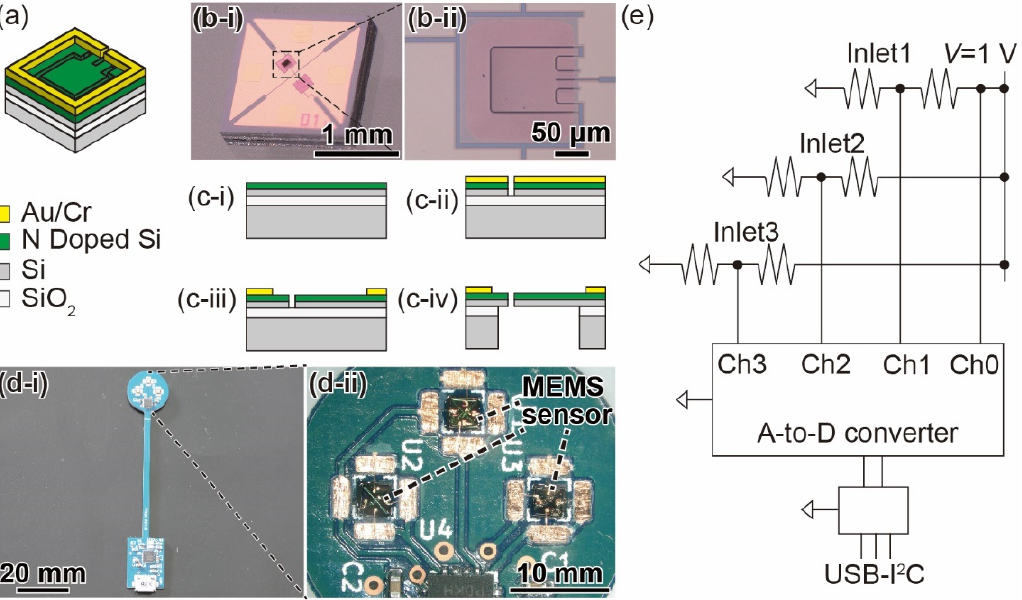
Figure 3. ( a ) Schematic diagram of the piezoresistive cantilever. ( b ) Photographs of ( i ) the MEMS DP sensor chip and ( ii ) the piezoresistive cantilever. ( c ) Fabrication process of the DP sensor. ( d ) Photo- graph of ( i ) overall and ( ii ) close-up of the substrate with the MEMS DP sensor chips. ( e ) Schematic image of the